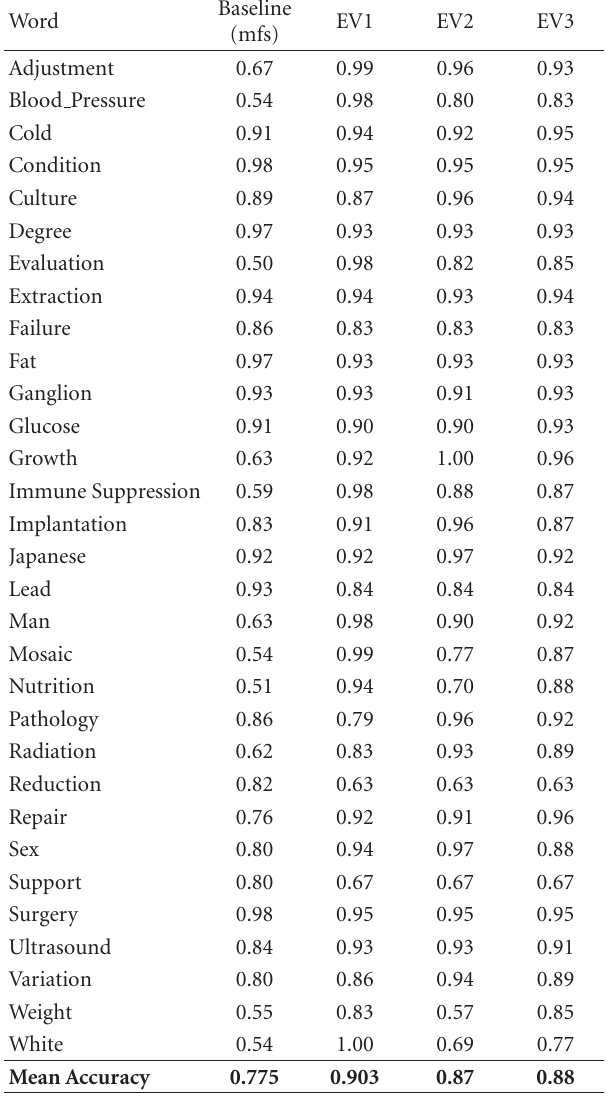
Table 5: Detailed accuracy results of three evaluations EV1, EV2, and